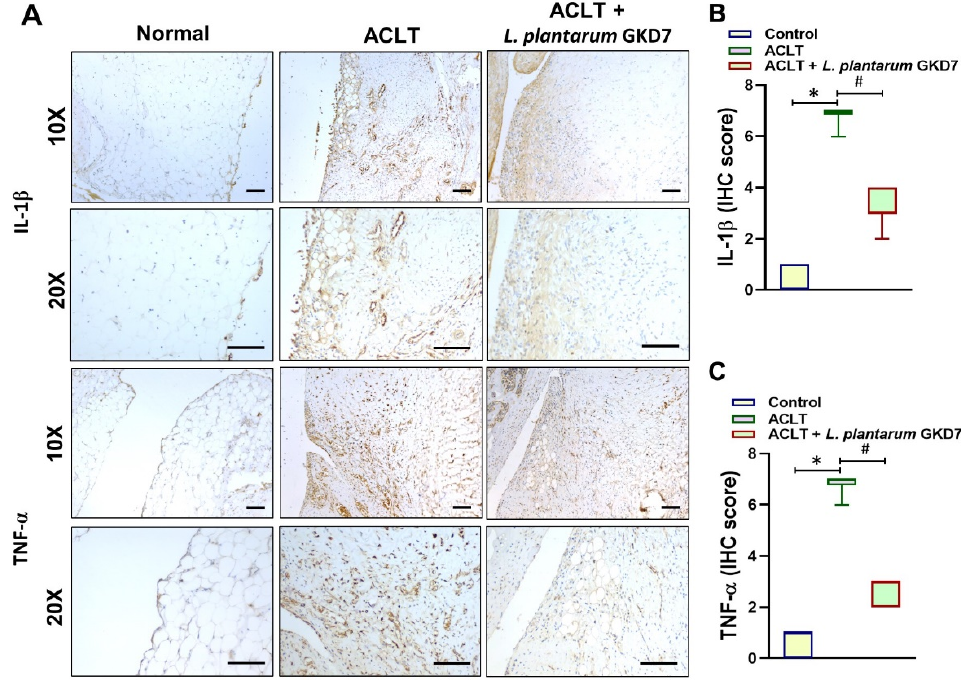
Figure 6. Oral live L. plantarum GKD7 reduced levels of TNF- α and IL-1 β expression in OA synovium. ( A ) IHC staining of IL-1 β and TNF- α in representative synovium from controls, ACLT-only rats, and ACLT + L. plantarum GKD7 rats. Quantitative analyses of ( B ) IL-1 β and ( C ) TNF- α in synovium. Scale bar = 100 µ m. * p < 0.05 vs. controls; # p < 0.05 vs. the ACLT-only group.